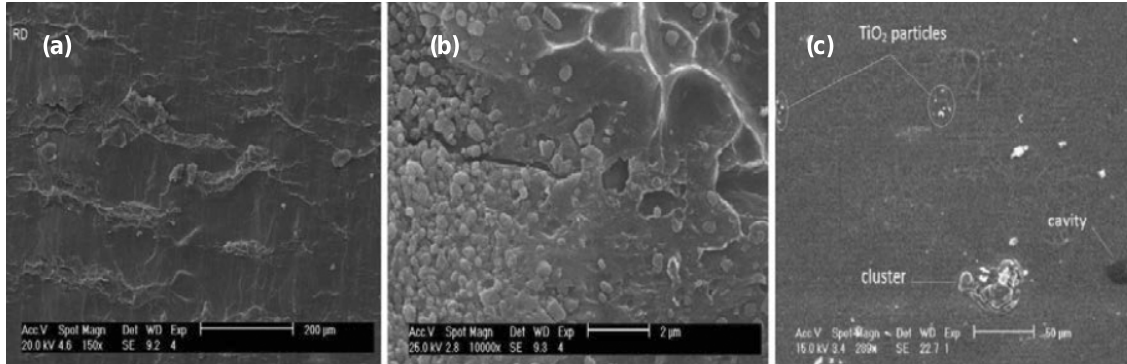
Fig. 5. The SEM micrograph of (a,b) the peeling surface and (c) side section of the Al-0.5 wt.% nanoparticles of TiO after seven ARB 2